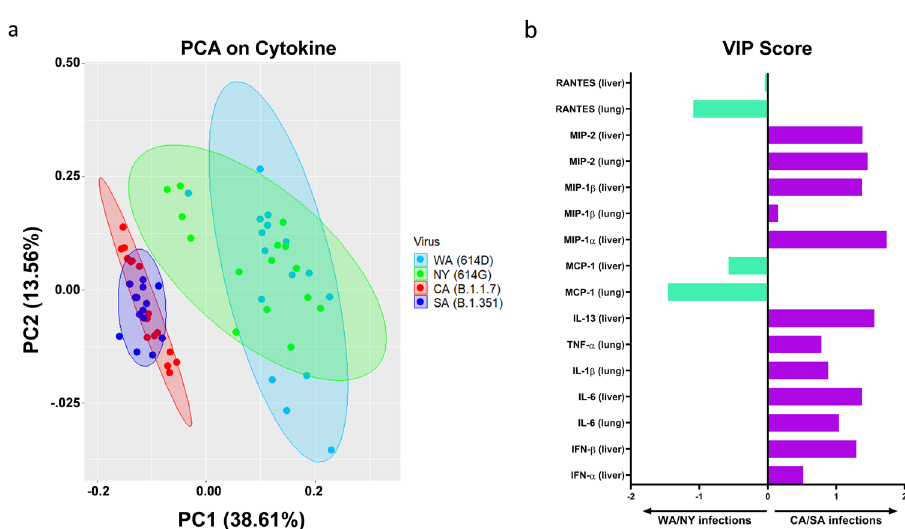
Fig. 6 Principal component analysis (PCA) and the variable importance in projection (VIP) score of tissue-speci fi c cytokines induced by infections of SARS-CoV-2 or variants. K18-hACE2 mice of both sexes (~1:1 ratio) were infected intranasally with USA-WA1/2020 (WA) of lineage A bearing 614D at 10 4 TCID 50 /mouse, New York-PV09158/2020 (NY) of lineage B.1.3 bearing 614G at 10 3 TCID 50 /mouse, USA/CA_CDC_5574/2020 (CA) of lineage